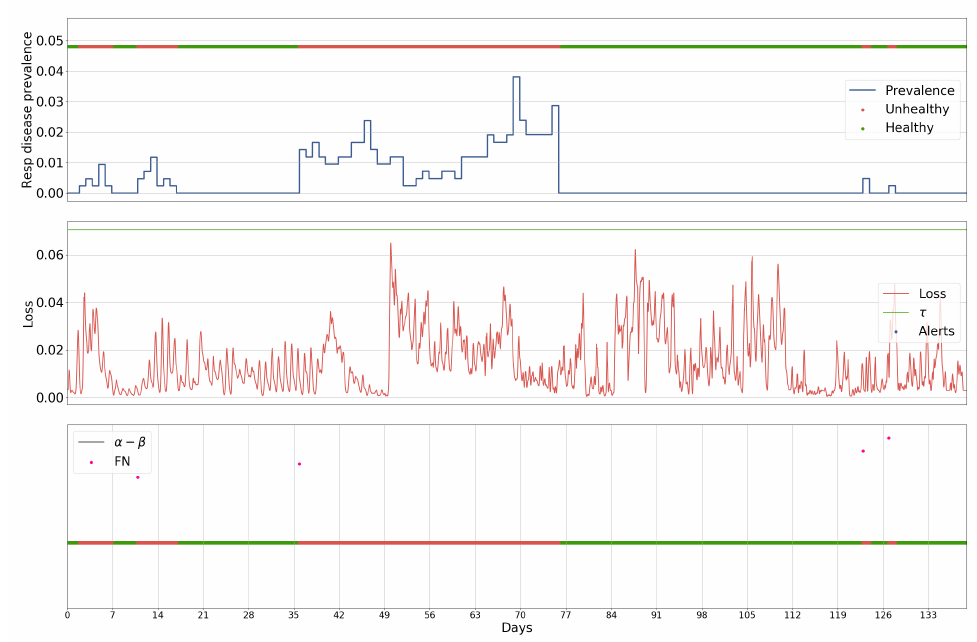
Figure 8. Results for batch 27 processed by the GRU-R-powered anomaly detection, given its PSO-optimised parameters α (the start of the window for which an alert is for), β (the length of the window), and τ (the threshold which the loss between predicted values and actual values must cross to be considered an alert), in relation to the prevalence of respiratory disease within a single batch.